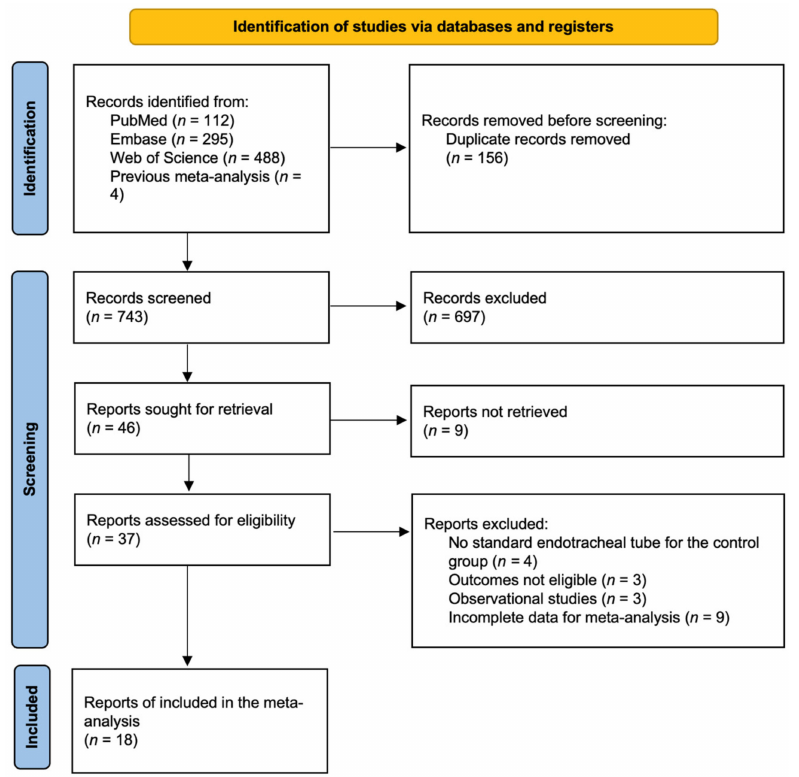
Figure 1. Preferred Reported Item for Systematic Review and Meta-Analysis flow